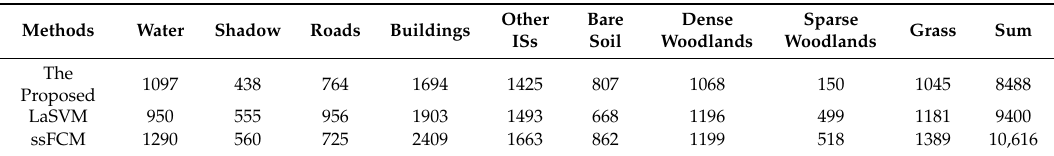
Table 7. The distances between true value and spectral curves modeled by ssFCM, LaSVM, and the hierarchical SSW-IT2FCM-O (wavelength: